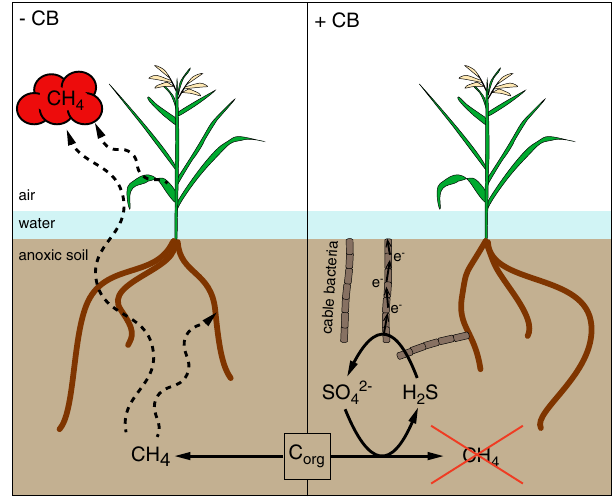
Fig. 4 Potential microbial-mediated processes. In rice-vegetated soils without cable bacteria (left) and with cable bacteria (right) organic carbon (C org ), e.g. from root exudation, is degraded by a consortium of microorganisms to acetate and hydrogen, which are the main substrates for methanogens. In soils with cable bacteria, increased sulfate concentrations due to e-SOX stimulate sulfate-reducing bacteria, which outcompete methanogens for common substrates. The produced CH 4 can enter to the atmosphere through the soil and the plants (dotted